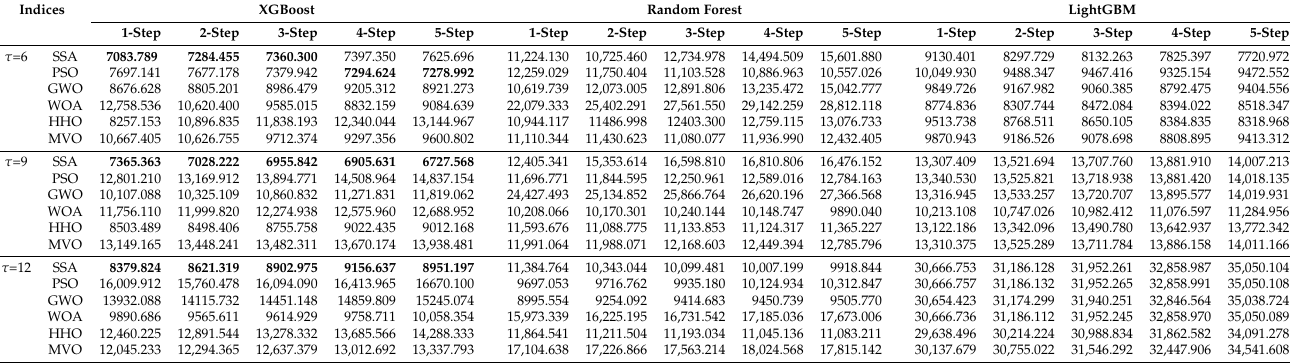
Table 7. RMSEs of multi-step ahead forecasting of the NGC of UK.